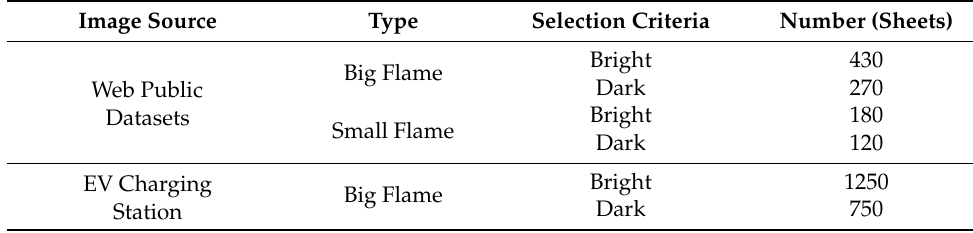
Table 1. Electric vehicle flame dataset information.